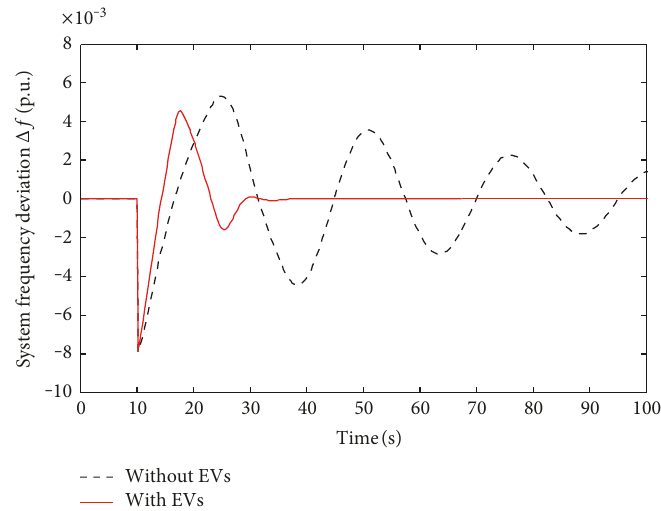
Figure 2: The frequency deviation with and without